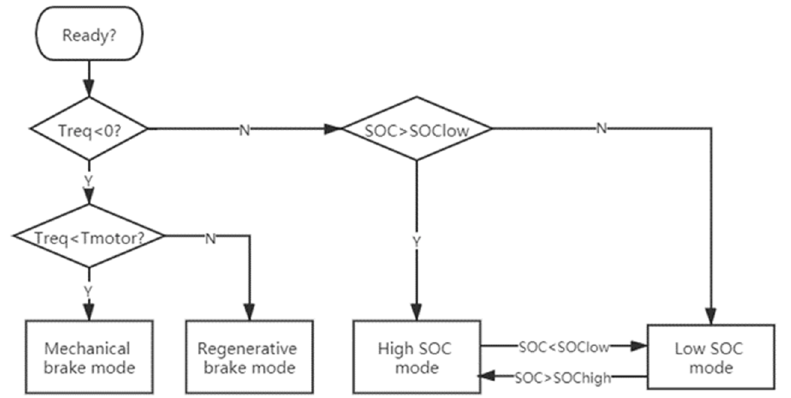
Figure 12. Dual fuzzy logic control strategy.